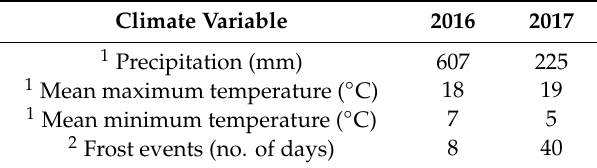
Table 1. Total precipitation, maximum and minimum monthly temperatures, and the number of frost events experienced at Wagga Wagga during the 2016 and 2017 growing seasons (May to November)